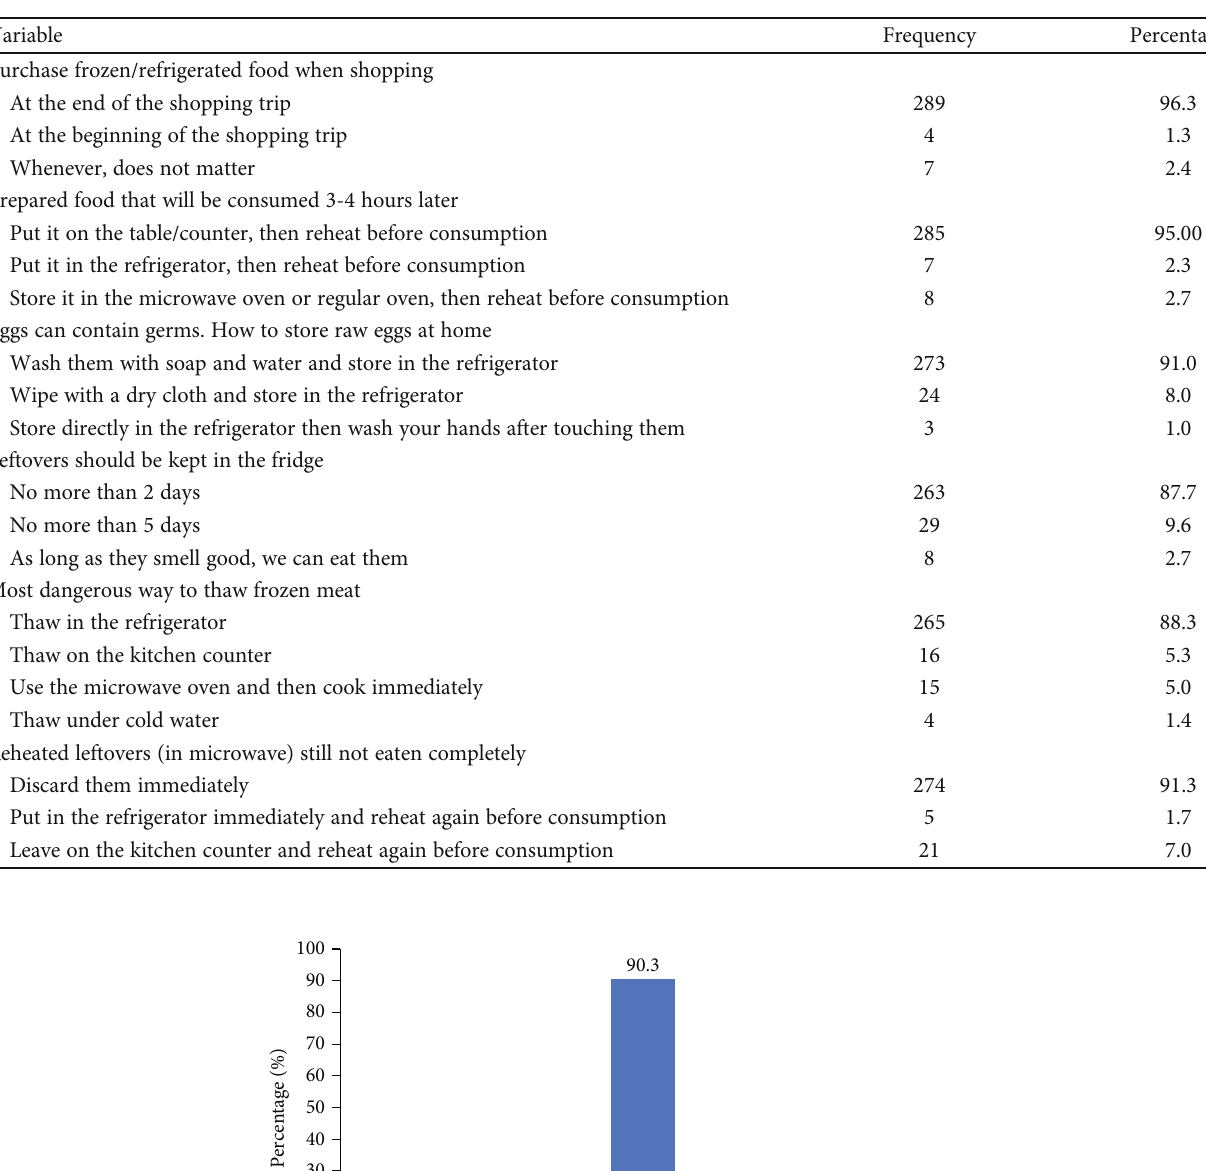
Table 4: Food storage practices among the respondents.